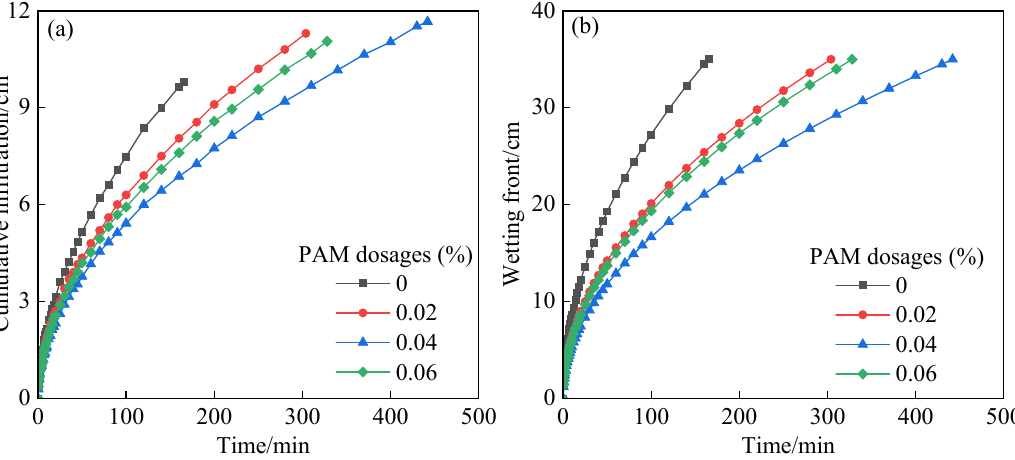
Figure 1. Effect of PAM dosages on soil infiltration characteristics of brackish water. (a) cumulative infiltration, (b)wetting front.